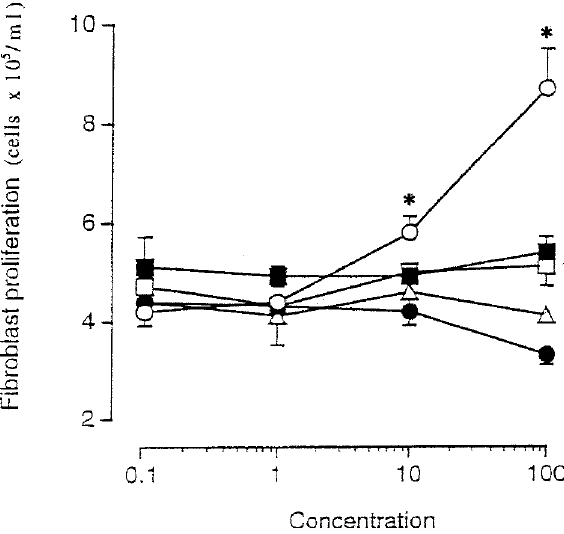
FIG. 1. Lung fibroblast cell proliferation due to PDGF (0.1–100ng/ml, open circles) and to heparin (0.1–100U/ml, closed circles), heparan sulphate (0.1–100 m g/ml, closed squares) de-N-sulphated heparin (0.1–100 m g/ml, open squares), and poly- L -gultamic acid (0.1–100 m g/ml, open triangles) in the absence of PDGF. The number of cells in the absence of any drug was 4.3±0.2 ´ 10 5 /ml. Each point presents the mean ands.e.mean derived from one of three experi- ments conducted with four replicates for each mean. p < 0.05 when compared to control.